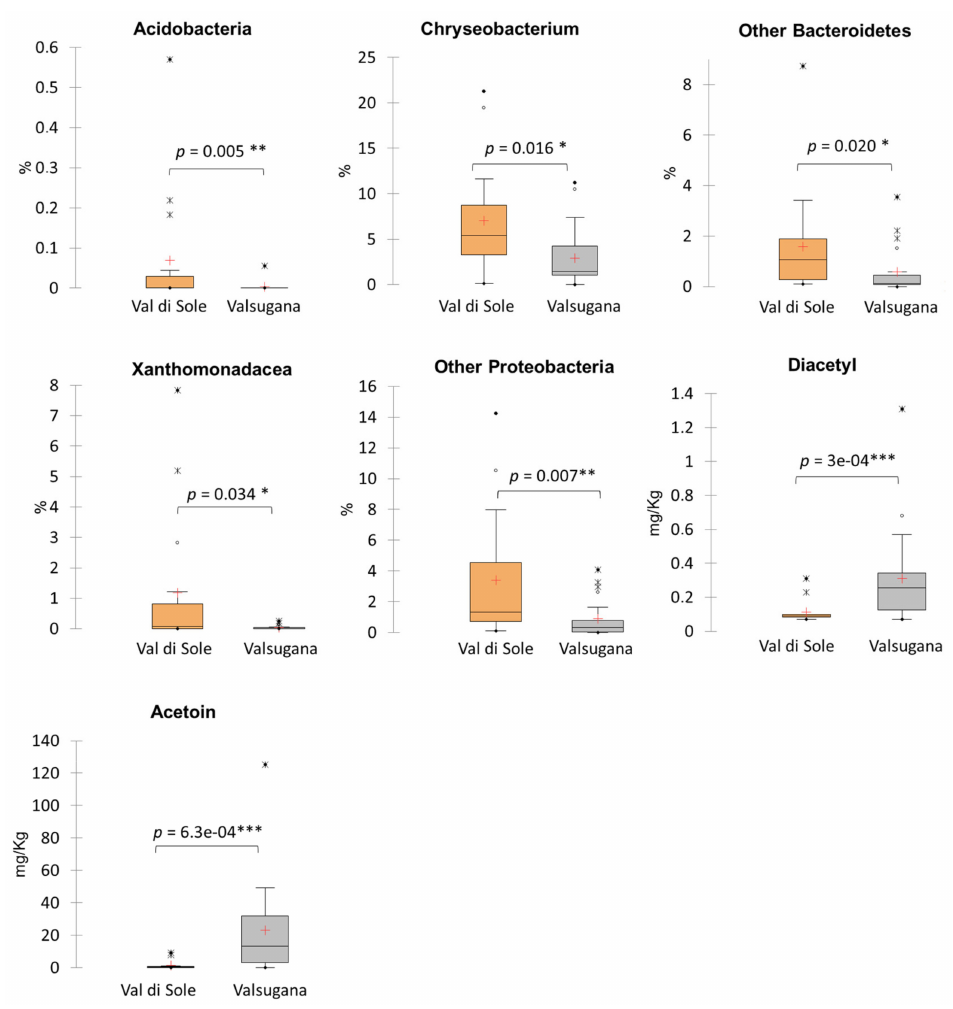
Figure 2. Box plot of the relative abundances (%) of Acidobacteria, Chryseobacterium, other Bacteroidetes, Xanthomonadaceae, other Proteobacteria, and the concentration of diacetyl/acetoin measured in the TMB of the two valleys in Trentino (Val di Sole, n = 17; Valsugana n = 25). Significance level: * p ≤ 0.05 significant; ** p ≤ 0.01 very significant; *** p ≤ 0.001 highly